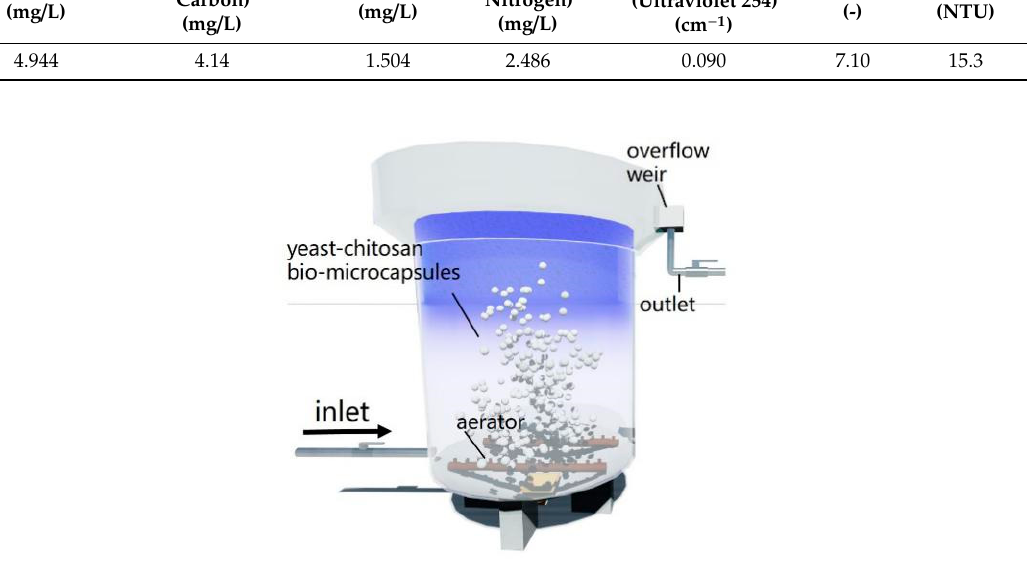
Figure 1. Bench-scale experimental setup: A cylindrical contact reaction tank connected with the membrane tank.